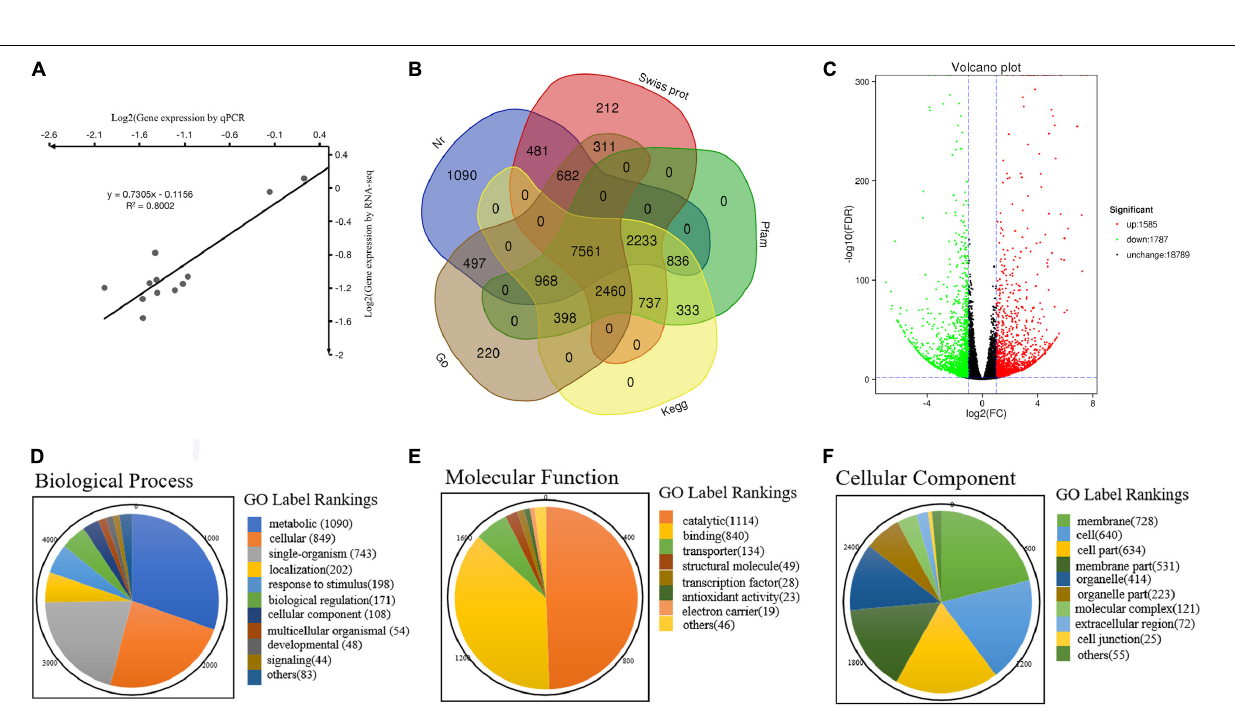
FIGURE 2 | Annotation information and functional annotation of DEGs in WT and yl mutant. (A) Correlation analysis of the RNA-seq data. (B) Venn diagram of the distribution of annotation information from different public databases. (C) The volcano plot of DEGs. (D) Biological process. (E) Molecular function. (F) Cellular